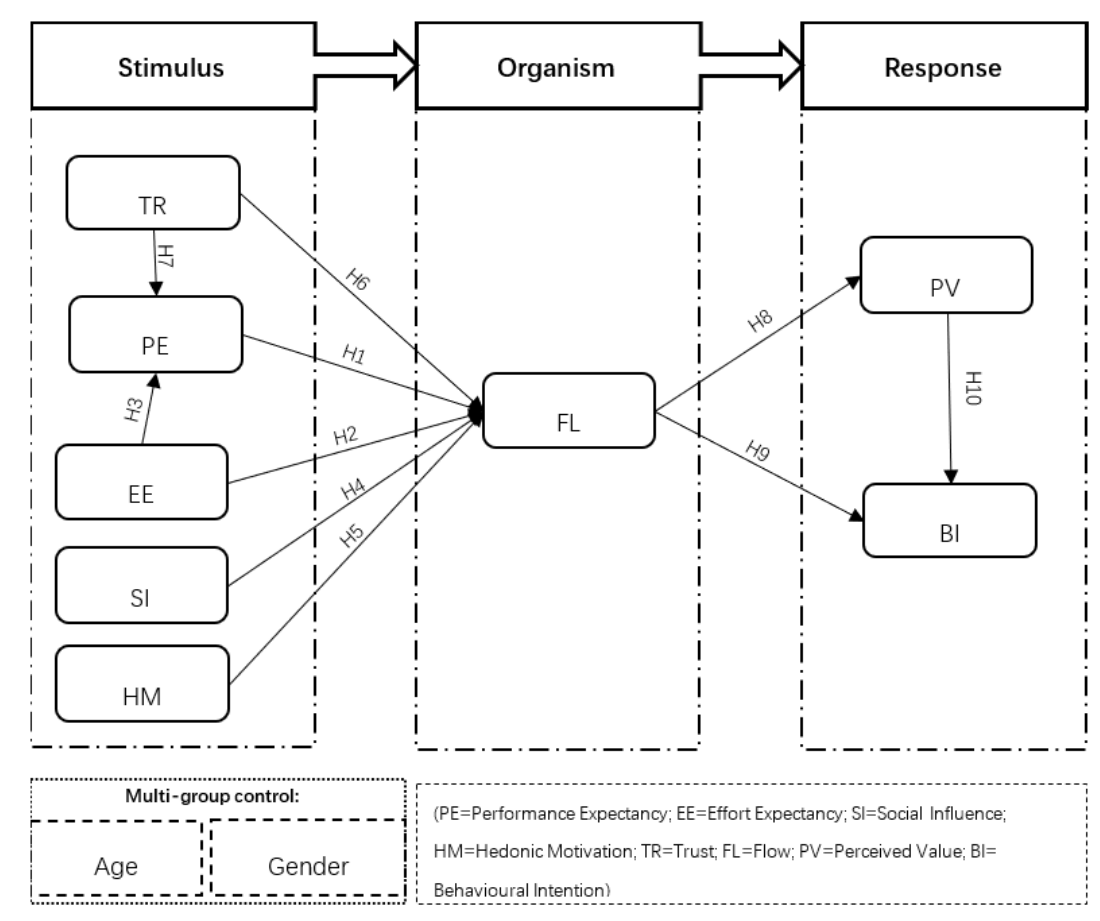
Figure 1. Proposed research model.